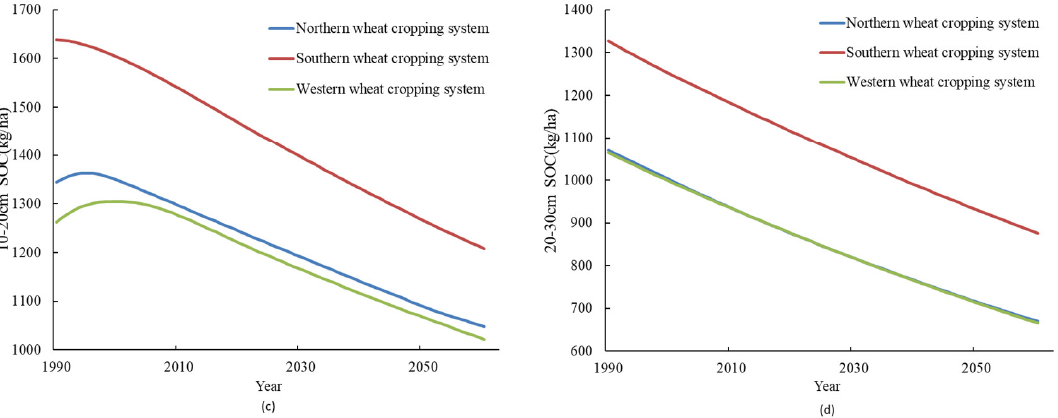
Figure 4. SOC changes during 1990–2060. ( a ) The 0–10 cm SOC change for the 19 observation sites. ( b ), ( c ), and ( d ) show 0–10, 10–20, 20–30 cm average SOC for the three wheat cropping regions, respectively. In ( d ), the lines representing the ‘northern wheat cropping system’ and ‘western wheat cropping system’ overlap.